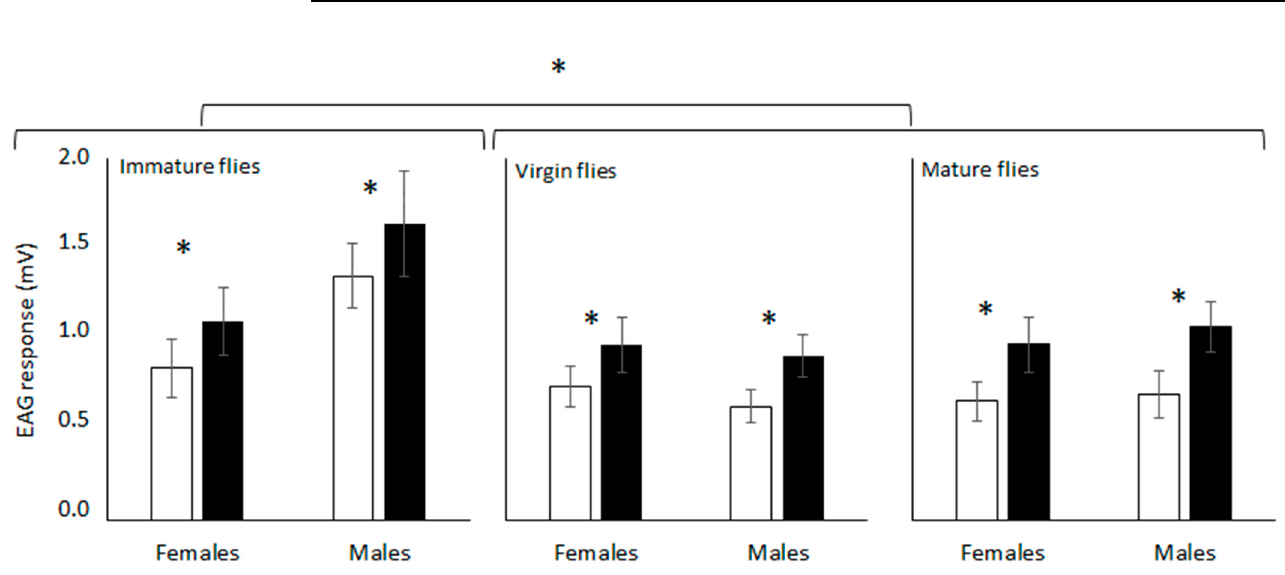
Figure 2. Average response (amplified signals expressed as mV) of Anastrepha fraterculus antennae from different physiological fly conditions to (±)- trans -tetrahydroactinidiolide (dimethyl; white bars) and epianastrephin (black bars) in electroantennography. Asterisk denote significant differences (DGC, α 0.05). Table 1. Results of the general lineal model built to analyze the antenna response (amplified signals expressed as mV) of A. fraterculus to the semiochemicals according to their sex (male or female) and physiological condition (age and mated status).